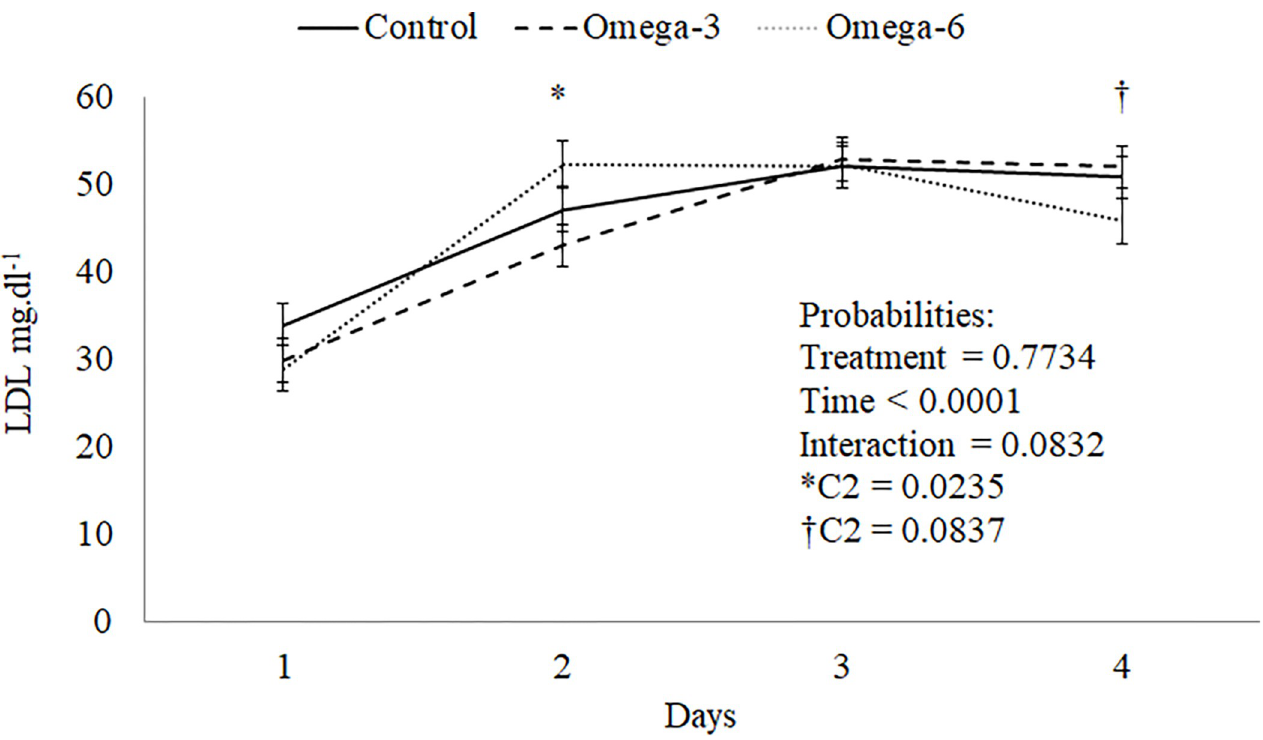
Fig 3. Behavior of the LDL curve at 77 days of gilts.